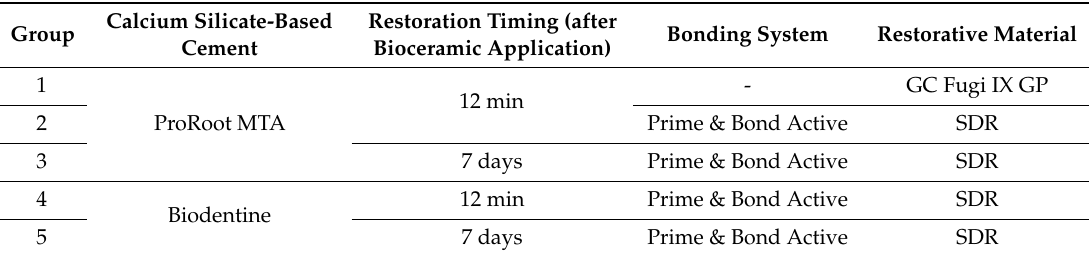
Table 2. Description of study groups, with biomaterials, restoration timing, bonding systems, and restorative